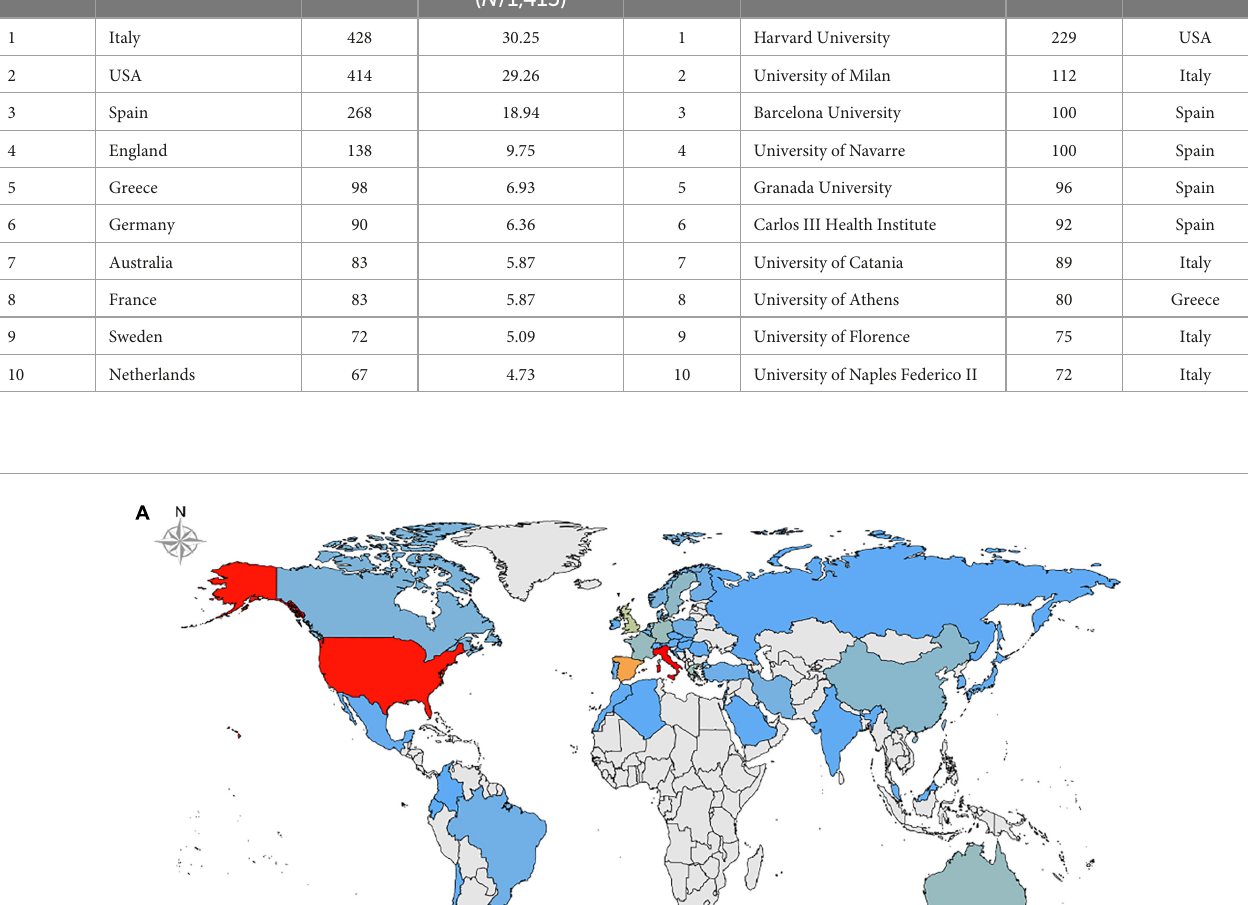
TABLE 1 Top 10 productive countries/regions and top 10 productive institutions related to the Mediterranean diet (MD) on cancer. Rank Country/region Percentage ( N /1,415)